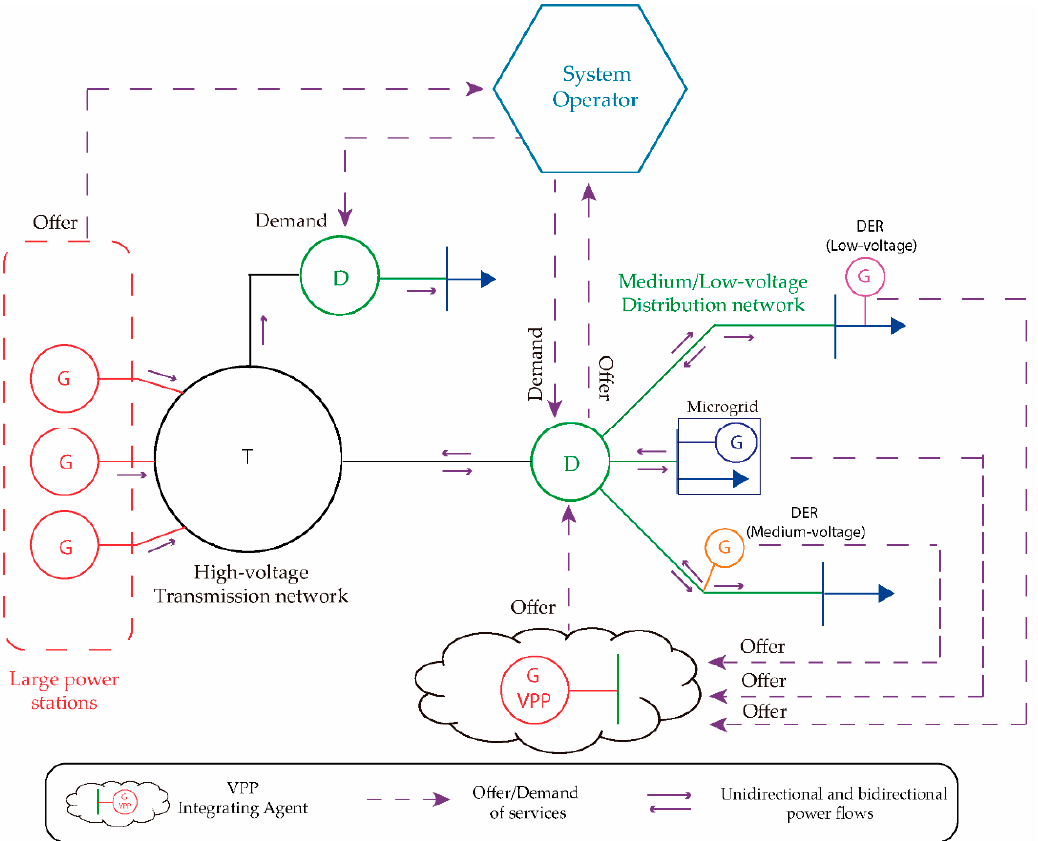
Figure 7. Centralized Operational Architecture .